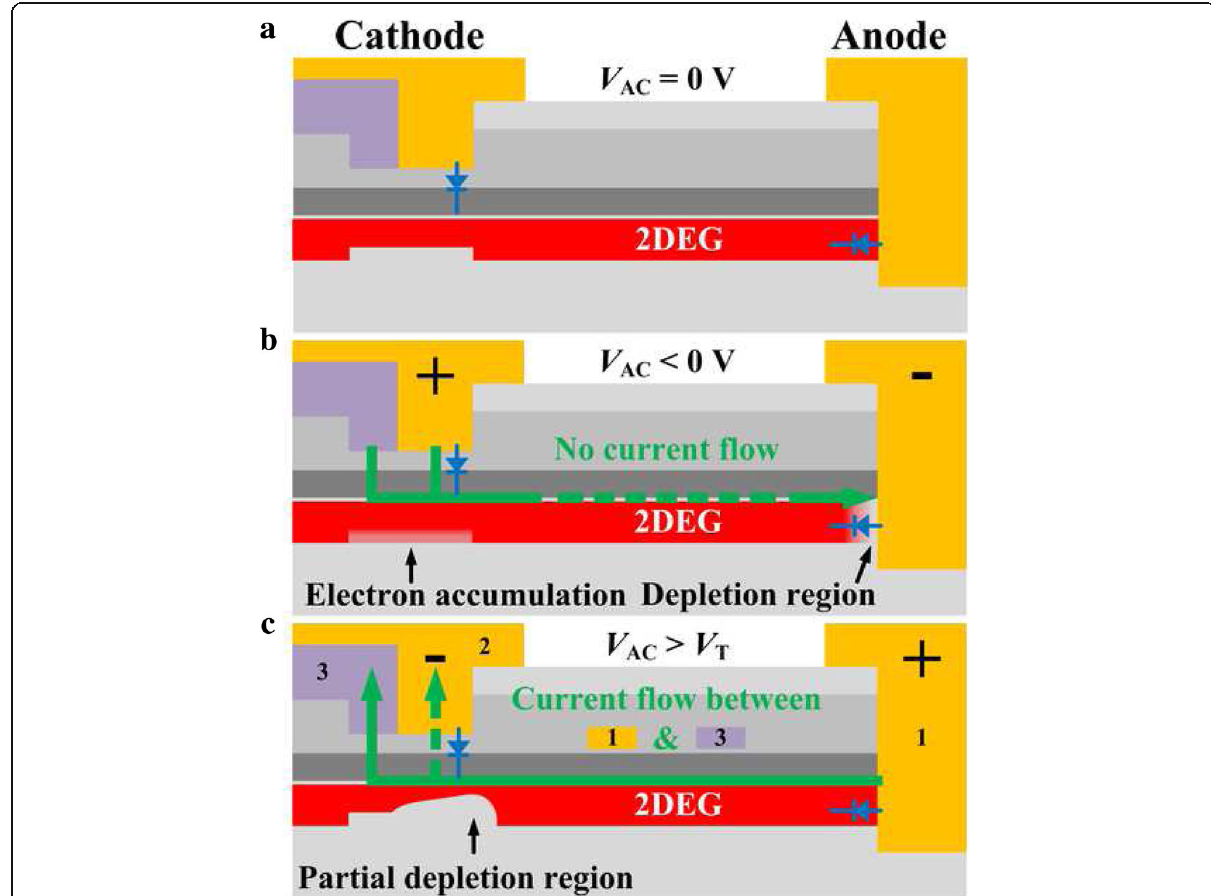
Fig. 4 Schematic operation mechanism of the RB-CRD under a zero bias, b reverse bias, and c forward bias